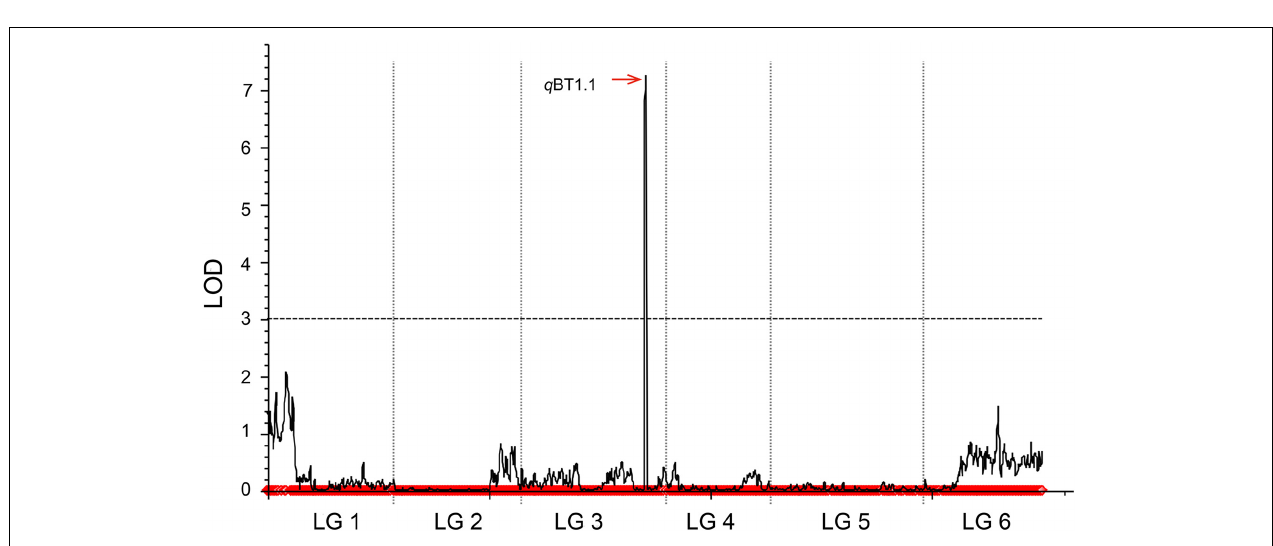
FIGURE 1 | The distribution of days to bolting in BC 1a , BC 1b , and F 2 spinach plants.